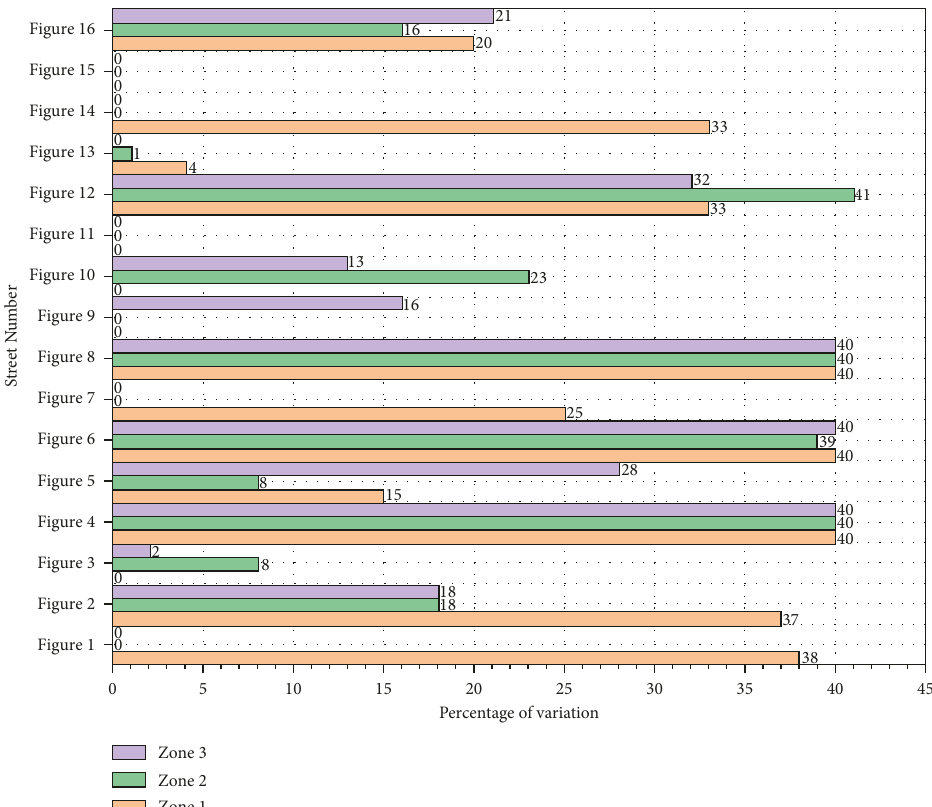
Figure 15: Percentage of variation between ESVI values of seismic intensity IX based on different collapse types.